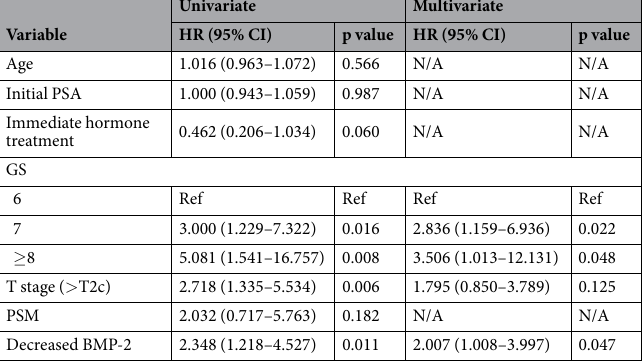
Table 4. Results of univariate and multivariate Cox-proportional hazard analysis of clinico-pathological parameters and BMP-2 expression were differentially expressed with regard to the biochemical recurrence- free interval after radical prostatectomy. BMP = bone morphogenetic proteins; CI = confidence interval; HR = hazard ratio; PSA = prostate-specific antigen; N/A = not applicable; PSM = positive surgical margin; GS = Gleason’s